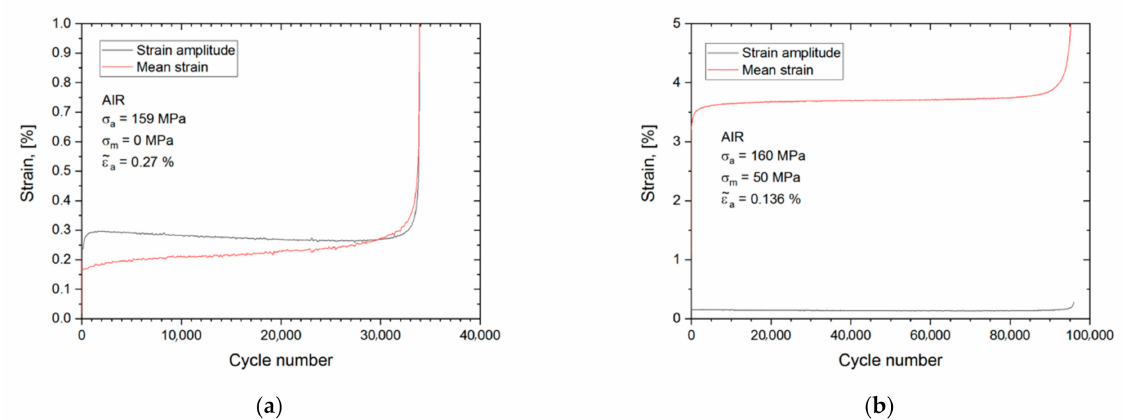
Figure 5. Strain amplitude and mean strain evolution versus cycle at a nominal stress amplitude of 160 MPa in air with: